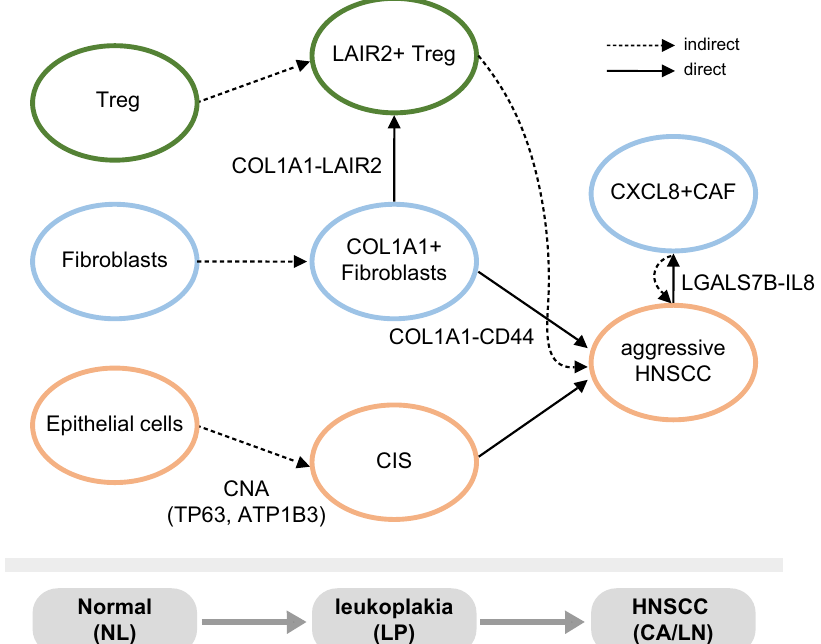
Fig. 7 | Graphical summary of the cell-cell interactions during stepwise HNSCC progression. The key fi ndings regarding the interactions among the malignant cells, fi broblasts, and immune cells are